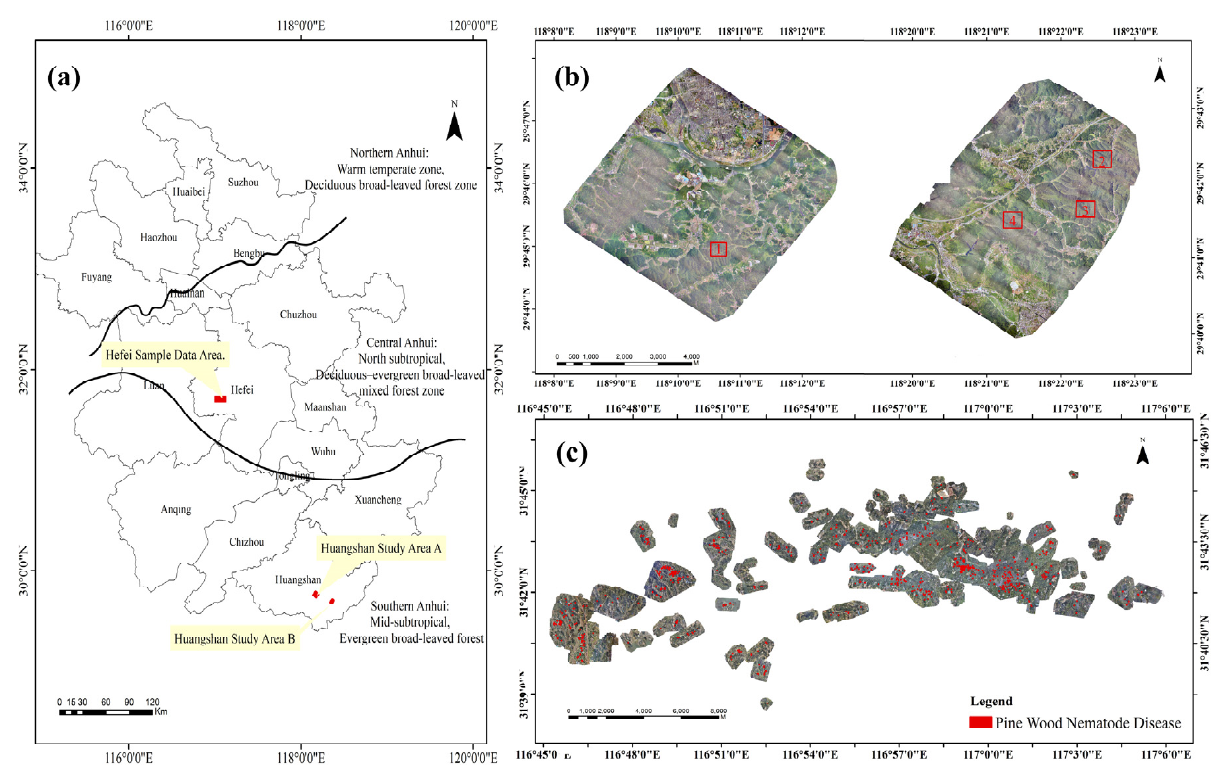
Figure 3. The experimental data. ( a ) Anhui Province regional map. ( b ) Huangshan study area. ( c ) Hefei sample data area.